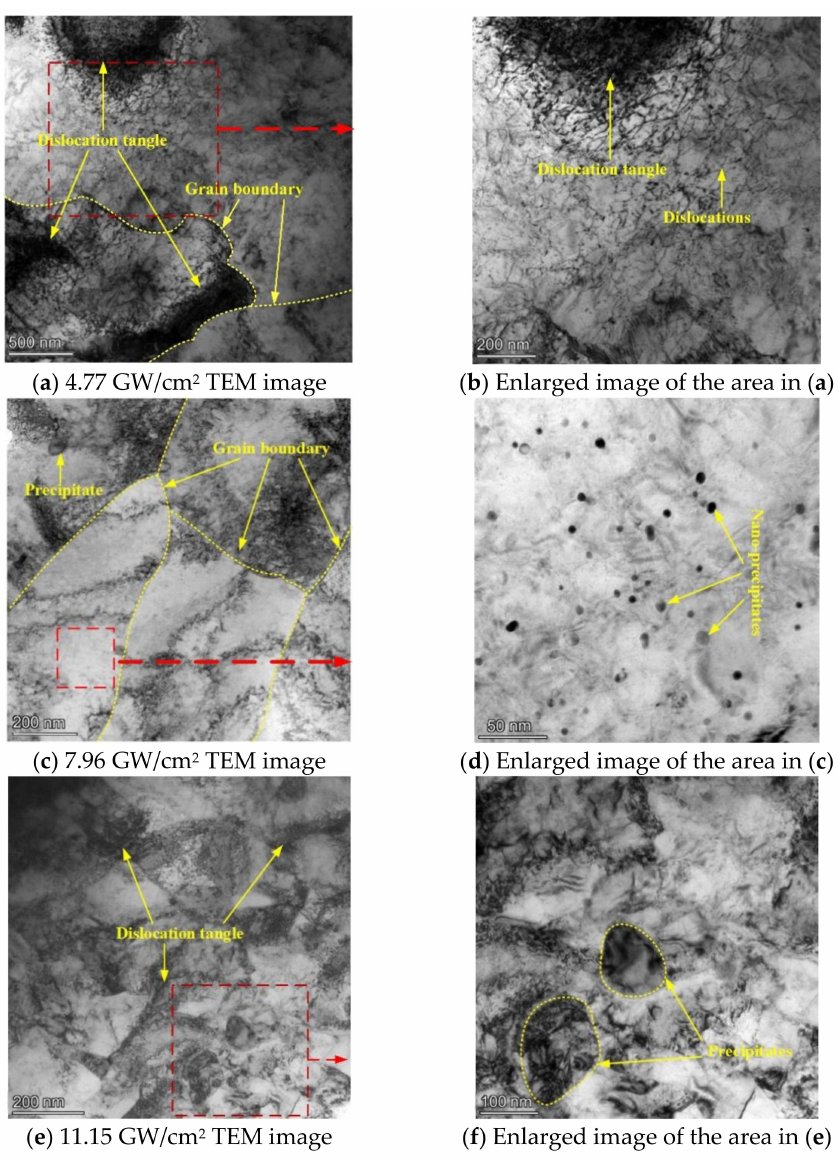
Figure 7. TEM images acquired after LSP at different power